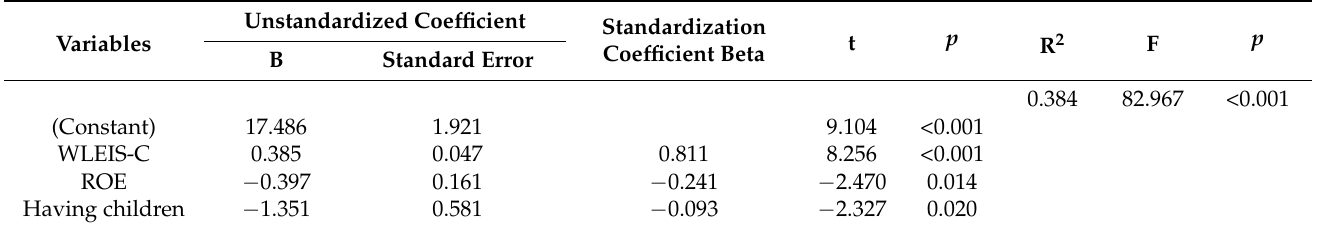
Table 3. Variables related to nurses’ ethical sensitivity (stepwise multiple linear regression, N =